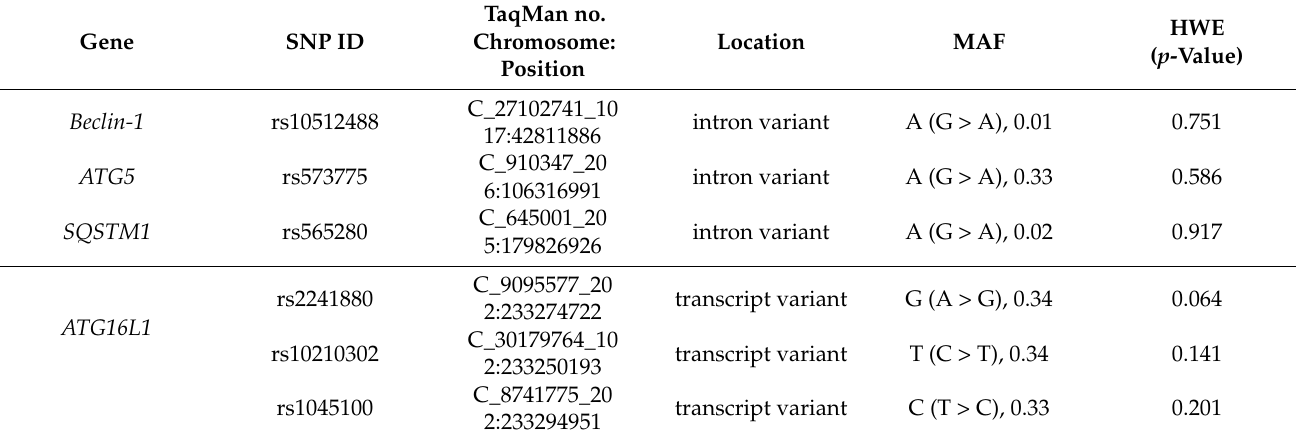
Table 1. Single-nucleotide polymorphisms of six-candidate genes potentially involved in the autophagy signaling pathway. TaqMan Gene SNP ID